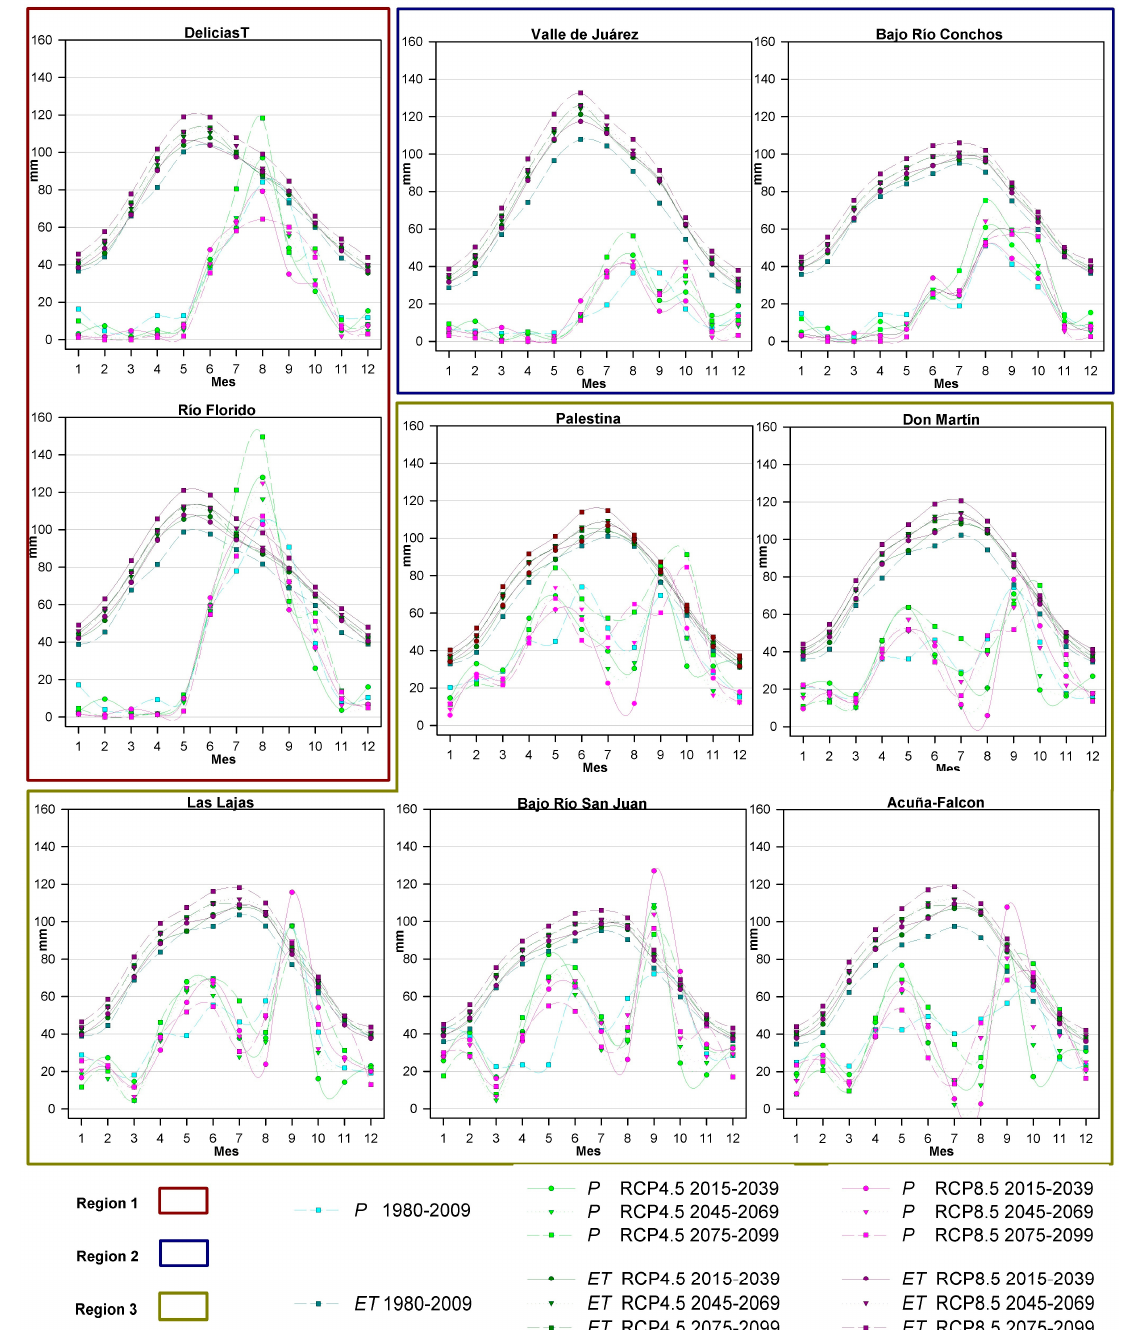
Figure 6. Monthly changes across the ID regions in average precipitation ( P ) and evapotranspiration ( ET ) for 1980–2009 in comparison to the RCP4.5 and RCP8.5 climate change scenarios projected for